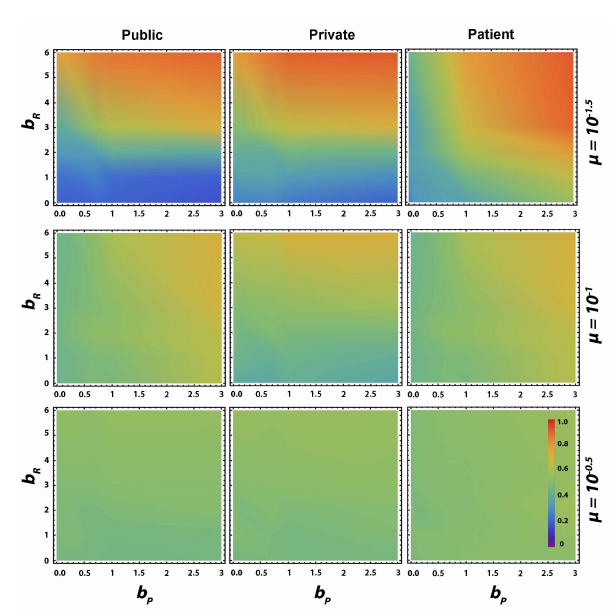
Figure 4. Cooperation levels in three populations for different values of µ . First column for P1 , second column for P2 , and third column for P3 . µ values are as specified on the right side. Other parameters as in Figure